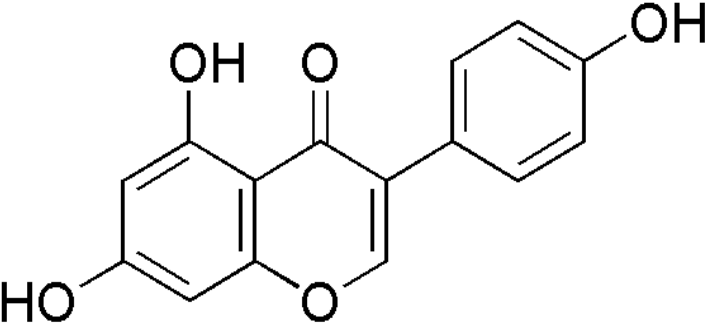
Figure 2. Chemical structure of genistein.